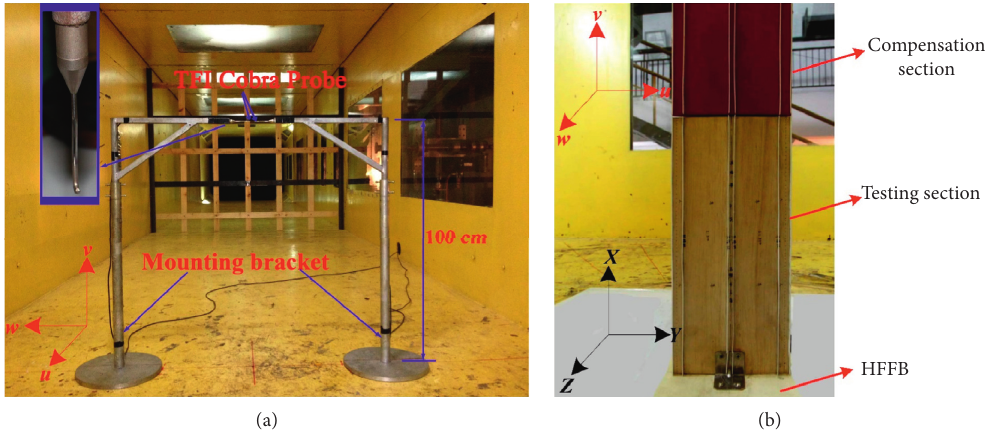
Figure 6: Testing of AAF in the wind tunnel: (a) measuring fluctuating wind speed; (b) the testing model. The directions u , v , and w correspond to the y , x , and z axes on the bridge, respectively. Table 3: Turbulence characteristics generated in the wind tunnel. Turbulent integral scales